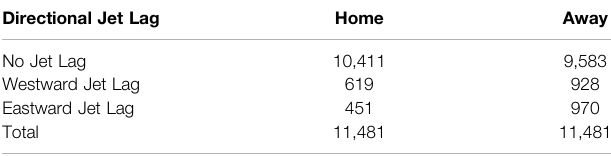
TABLE 1 | Directional Jet Lag Occurrences (Games) for Home and Away